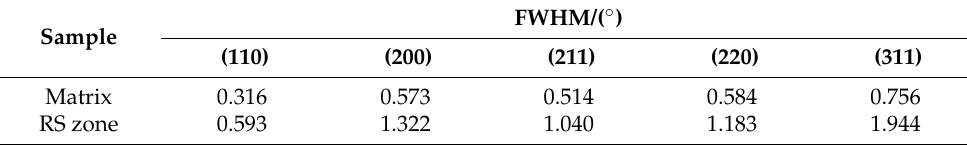
Table 5. Full-wave at half maximum (FWHM) in the matrix and RS zone of the test steel.